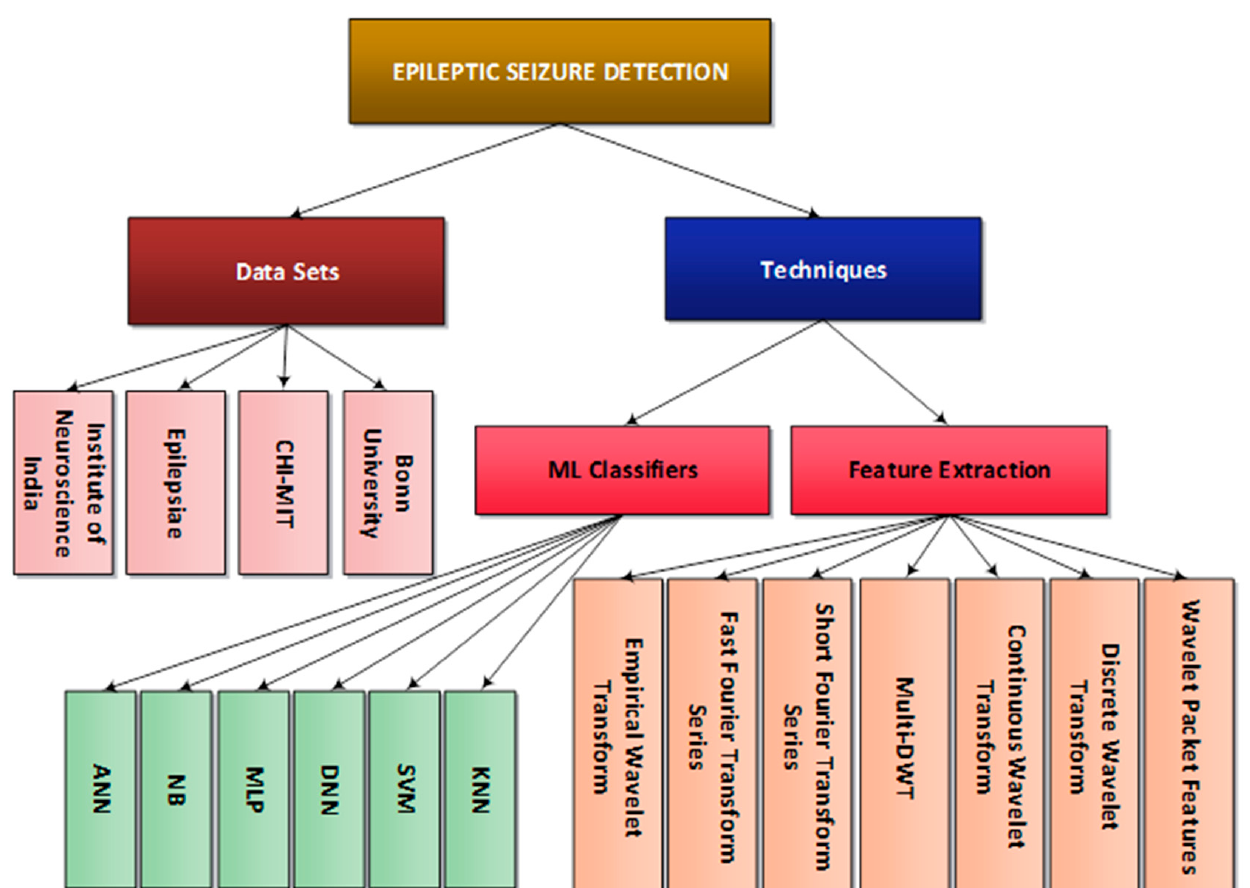
Figure 5. A hierarchal Taxonomy of Epileptic Seizure Detection Techniques.